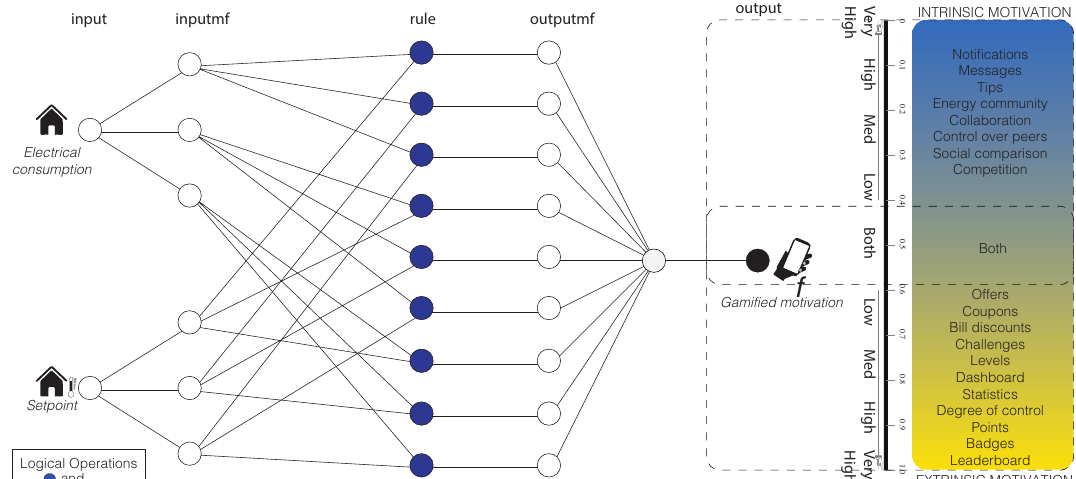
Figure 8. ANFIS model